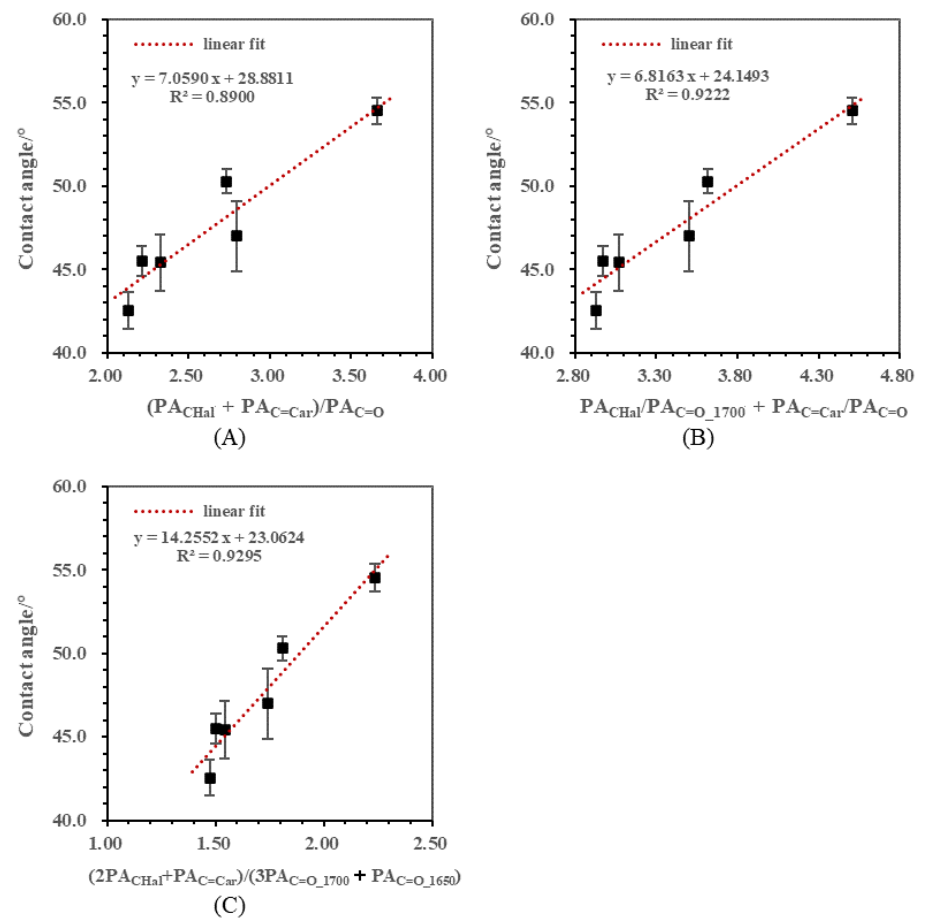
Figure 7. Correlations between contact angles and comprehensive semi-quantitative ratios. ( A ) Correlation between contact angle and (PA CHal + PA C=Car )/PA C=O ; ( B ) Correlation between contact angle and PA CHal /PA C=O_1700 + PA C=Car /PA C=O ; ( C ) Correlation between contact angle and (2PA CHal + PA C=Car )/(3PA C=O_1700 + PA C=O_1650 ).